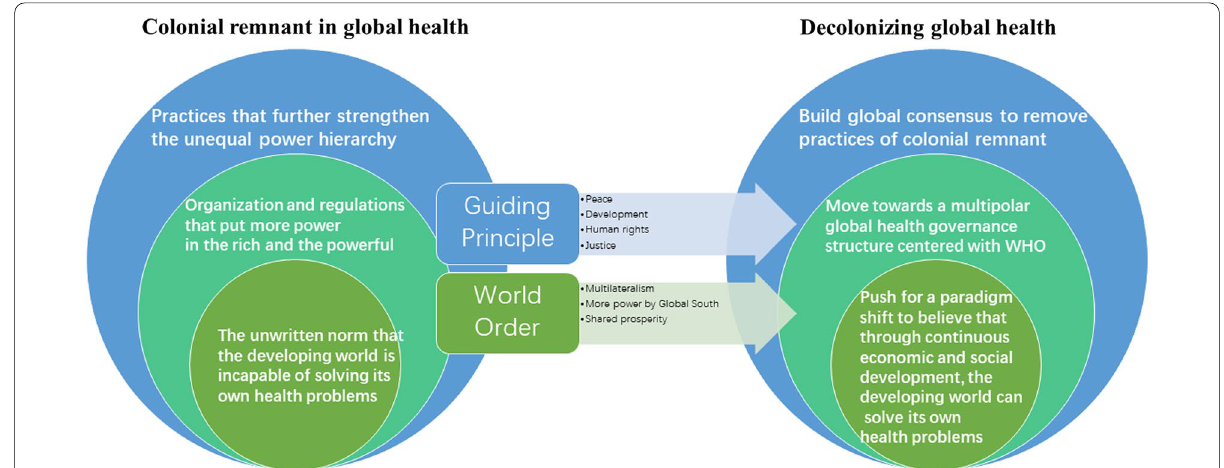
Fig. 1 Three levels of colonial remnant in global health and their corresponding